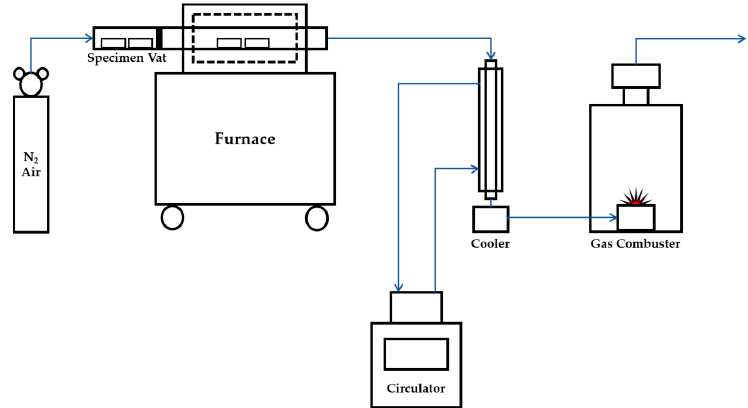
Figure 1. Construction drawing of pyrolysis experiment device.